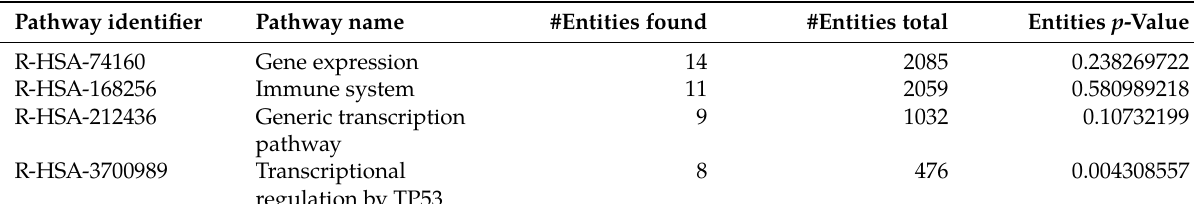
Table 1: Excerpt of the enrichment report created using Reactome based on the miRNA ’ s targets of